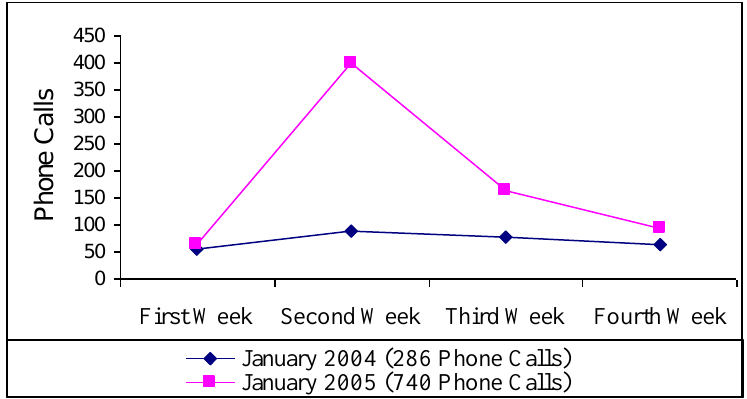
Figure 3. Comparison with number of calls received in January 2004 and in January